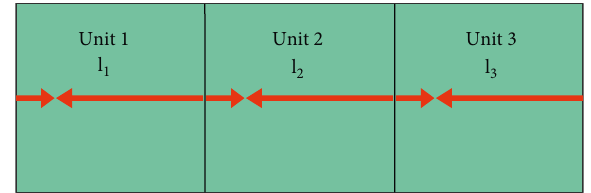
Figure 2: Sketch of a shell